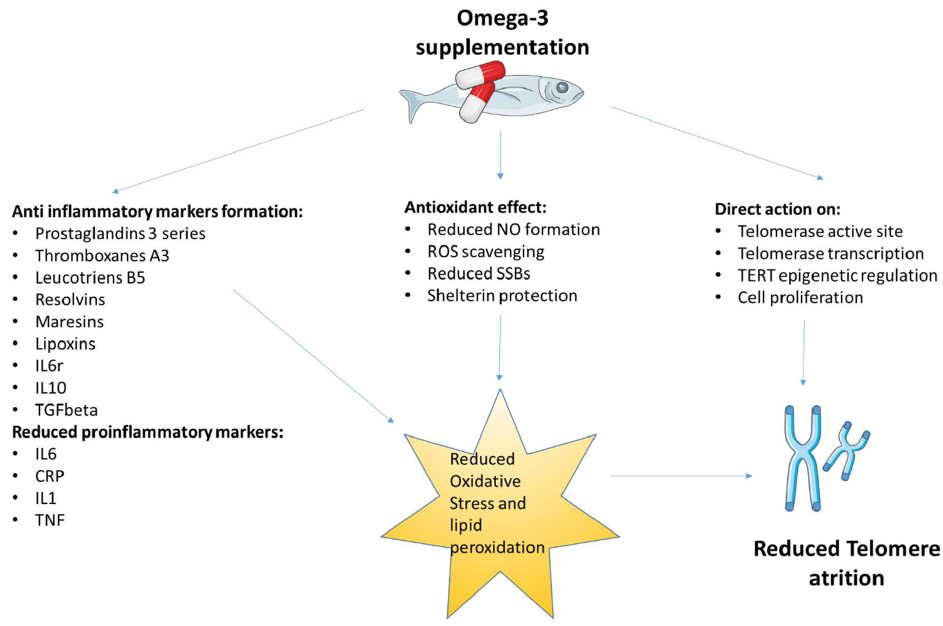
Figure 1. Indirect and direct effects of omega-3 fatty acid supplementation on telomere attrition. Author Contributions: Conceptualization, M.O. and R.R.S.; investigation, M.O., P.L. and R.R.S.; writing—original draft preparation, M.O., P.L. and R.R.S.; writing—review and editing, M.O., P.L. and R.R.S.; visualization, M.O. and R.R.S.; supervision, P.L. and R.R.S.; funding acquisition, M.O. and R.R.S. All authors have read and agreed to the published version of the manuscript.